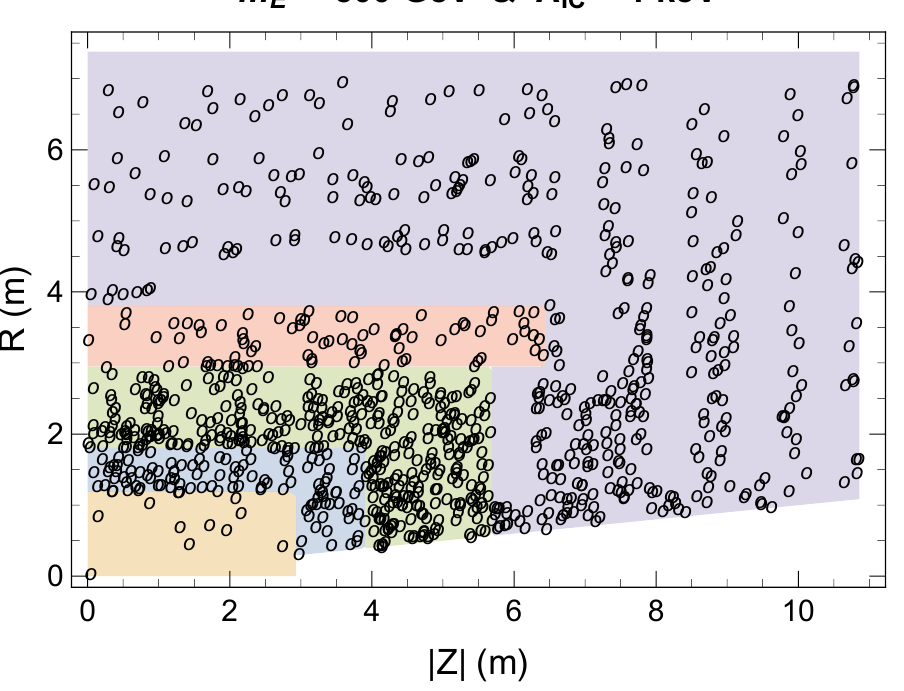
oo oo ooo oo ooo oo oo oo oo oo ooo oo ooo oo oo oo ooo oo oo oo oo oo oo oo ooo oo oo oo oo ooo oo oo oo ooo oo oo o oo ooo oo oo ooo o oo oo oo oo oo oo oo oo ooo oo oo oo o oo oo oo oo Figure 7 . Positions where 983 E 0 -like quirks with m E 0 = 500 GeV and (cid:3) IC = 1 keV stop in the CMS detector within a quadrant of ( R; j Z j ). Moving outwards we have the tracker (gold), ECal (blue), HCal (green), magnet (red), and muon system (purple). The most dense systems (HCal, MS iron return yokes) stop the most particles, while the least dense (tracker, MS drift tubes) stop very few. Many quirks are seen to stop at high values of (cid:17) , motivating an extension of the calorimeter (cid:17) range used in the out-of-time